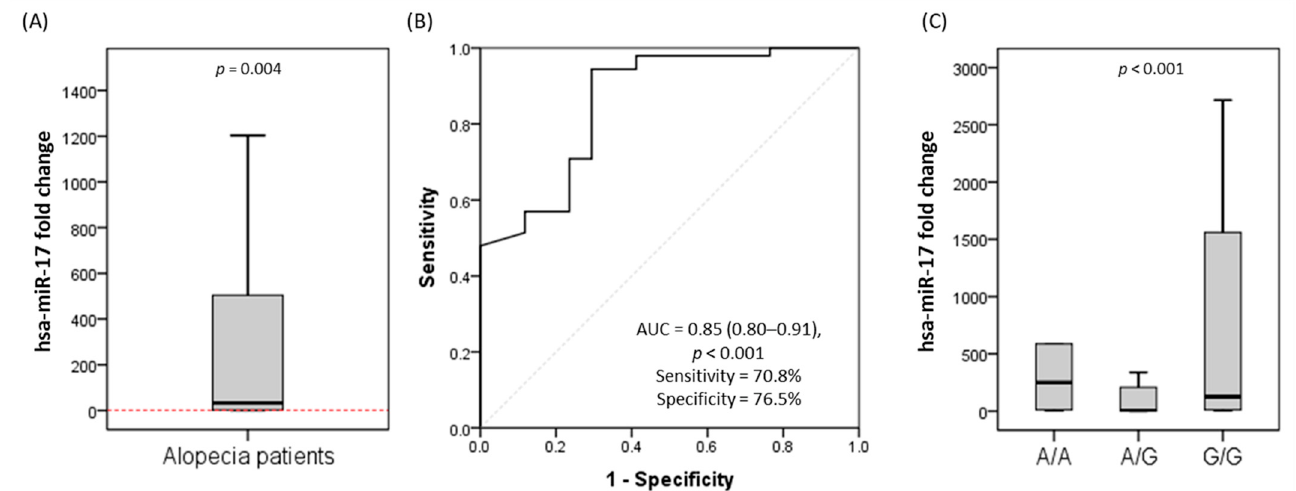
Figure 3. The relative expression levels of serum miR-17 in patients and controls. ( A ) Fold change in the alopecia patients compared to controls. Values are represented as the medians. The box defines the upper and lower quartiles (25% and 75%, respectively), and the error bars indicate the upper and lower adjacent limits. The red dotted line indicated the control group’s expression level. The Mann–Whitney U test was used. ( B ) Receiver Operator Characteristics curve for differentiating between patients and the control. The model was significant ( p < 0.001). ( C ) Comparing patients’ expression levels with different genotypes. The Kruskal–Wallis test was used. Pairwise comparisons were adjusted by the Bonferroni correction for multiple testing.